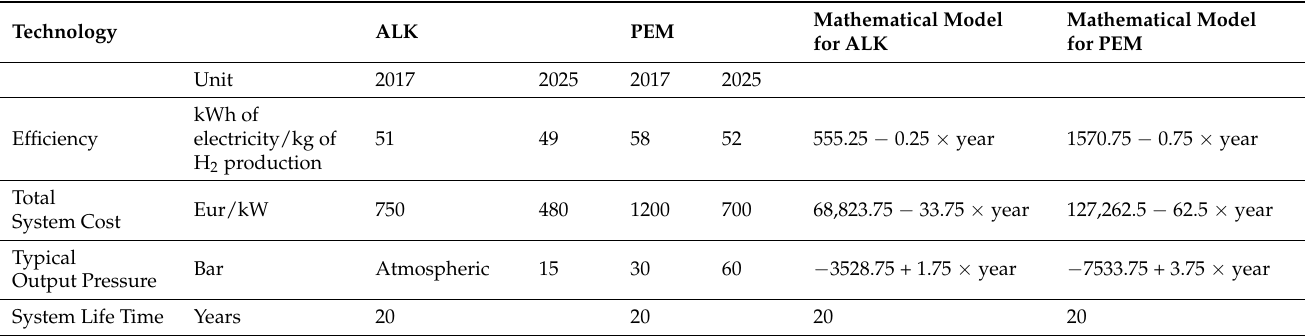
Table 2. ALK and PEM development models from 2017 to 2025